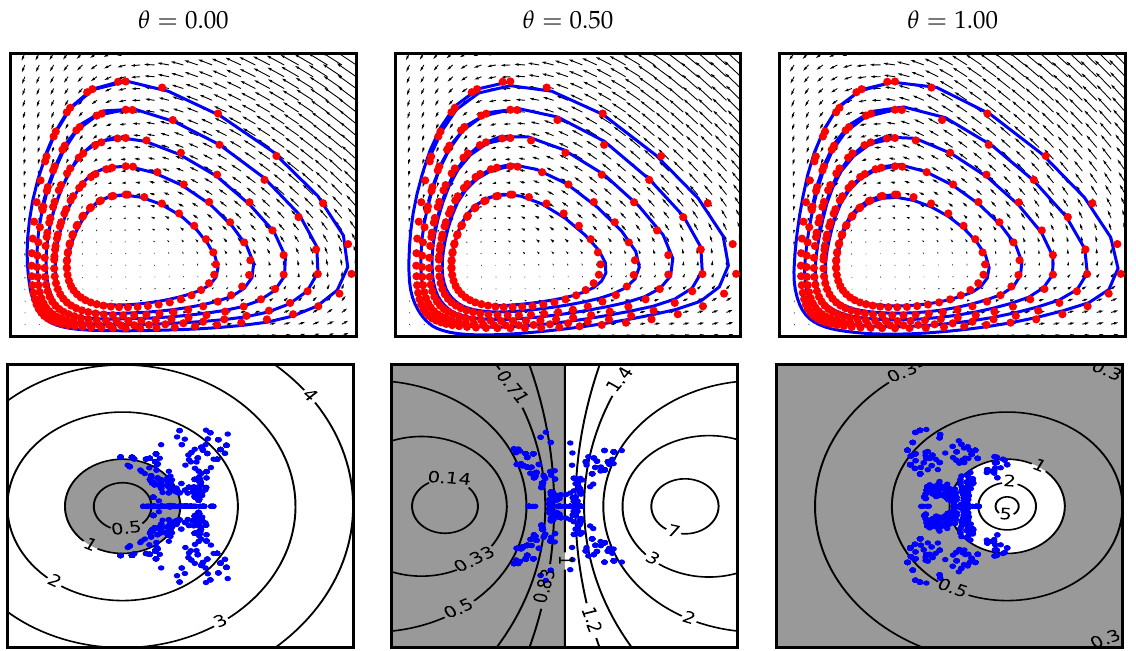
Figure 10. ( Top ) Learned vector fields and trajectories for the system in Example 3 on the time interval t ∈ [ 0,10 ] . ( Bottom ) Eigenvalues of the vector fields along these